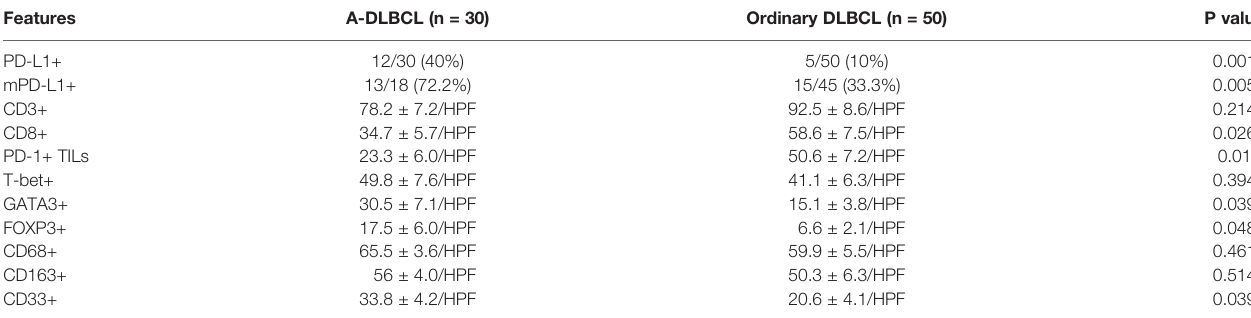
TABLE 3 | Comparison of TME markers and checkpoint molecules between A-DLBCL and ordinary DLBCL.